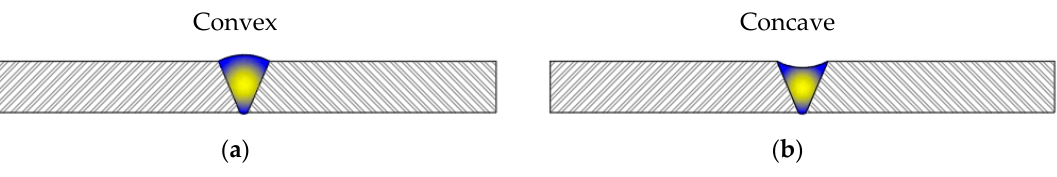
Figure 6. Schemes of hybrid laser-arc welding process and parameters.